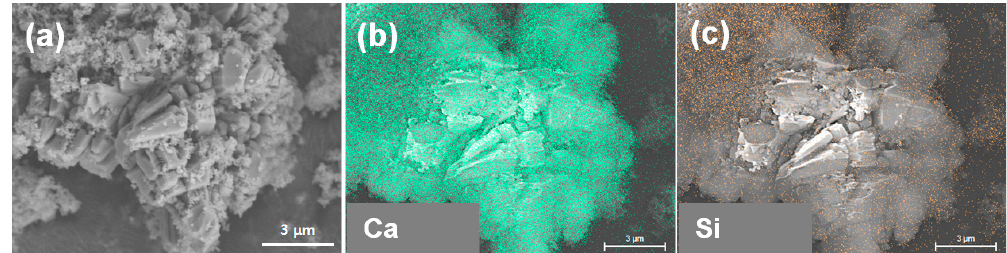
Figure 15. ( a ) FE-SEM image of composite particles, and the corresponding EDX mapping images of ( b ) Ca and ( c ) Si.